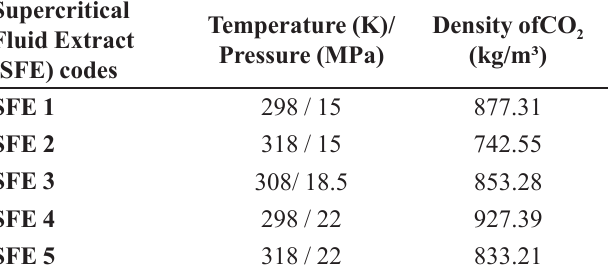
TABLE I - Supercritical fluid extraction conditions for P. mucronata